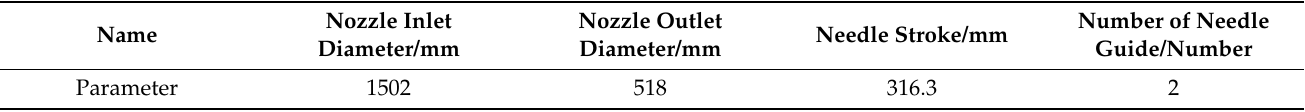
Table 2. Design parameters of the Pelton turbine